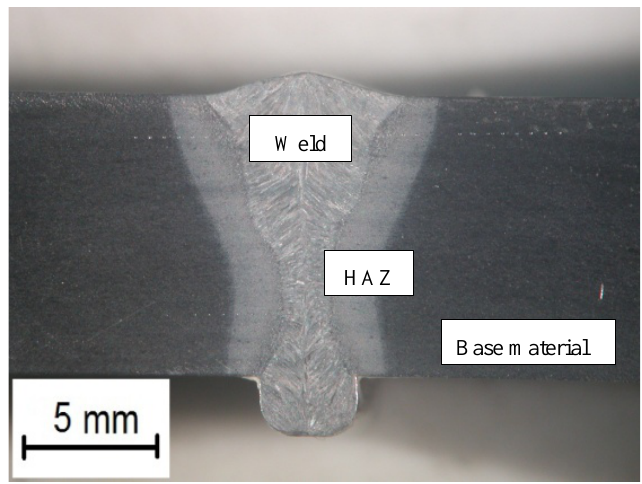
Figure 8. Macrostructure of the hybrid welded joint (laser beam-MAG) made in steel S700MC. HAZ: heat-affected zone.